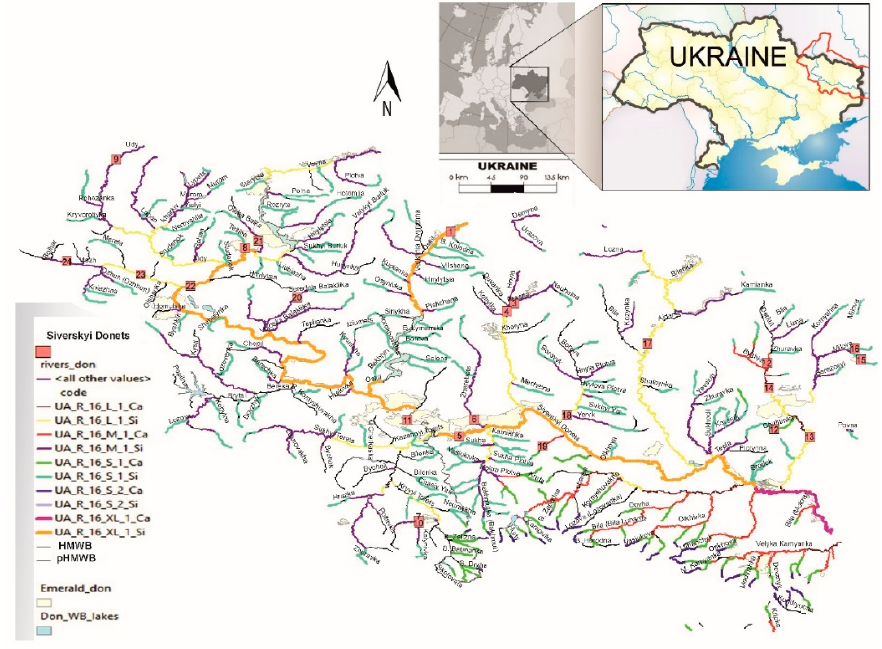
Figure 1. Map of the Siversky Donets river basin (Ukrainian part) with types of water bodies within the basin: 1—Oskil river, 2—Derkul river (near Bilovodsk village); 3—Krasna river (near N.